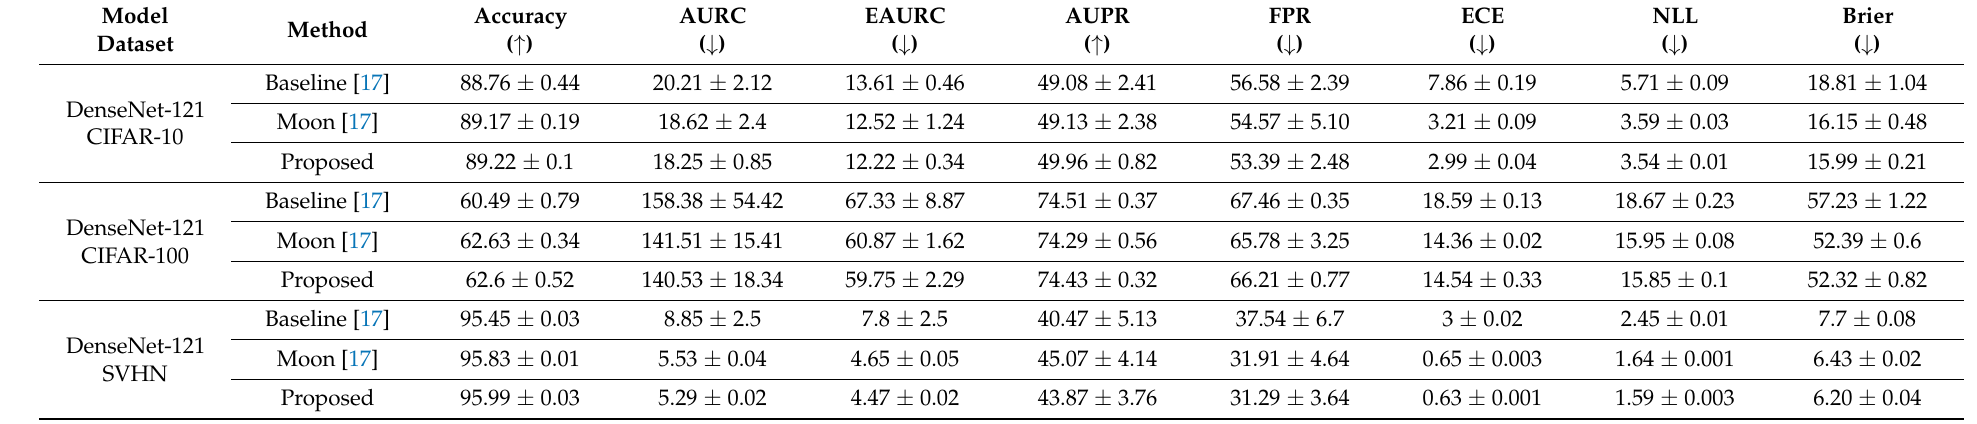
Table 3. Experimental results based on DenseNet-121